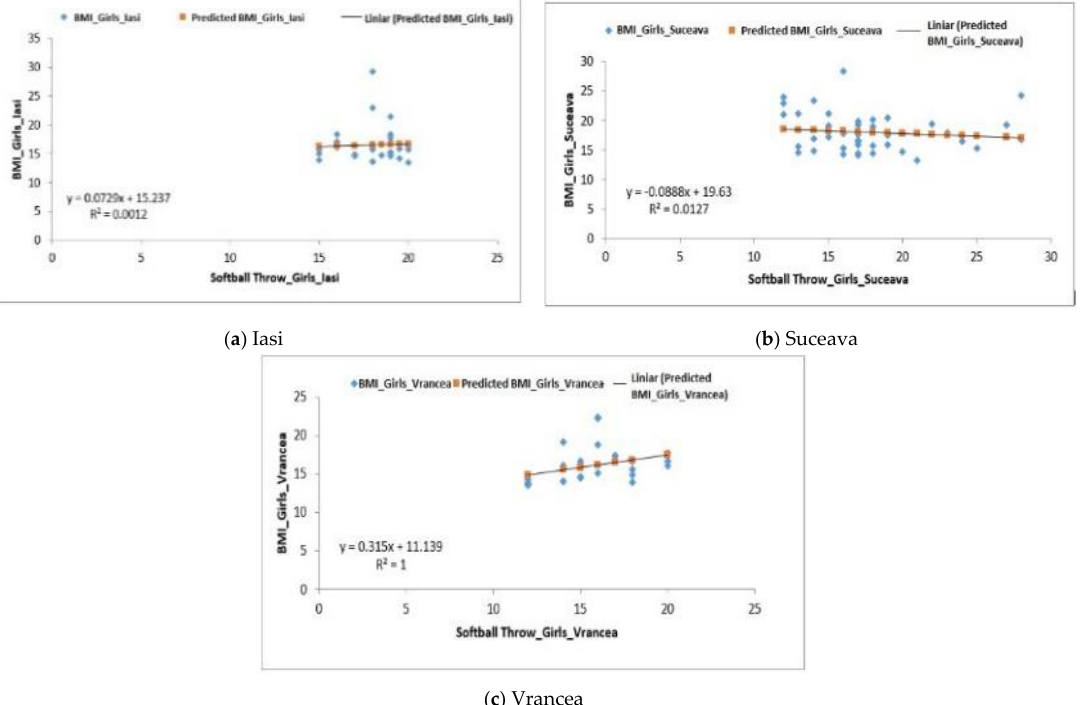
Figure 4. Relationship between the BMI and the softball throwing test for the female subjects in the three regions.